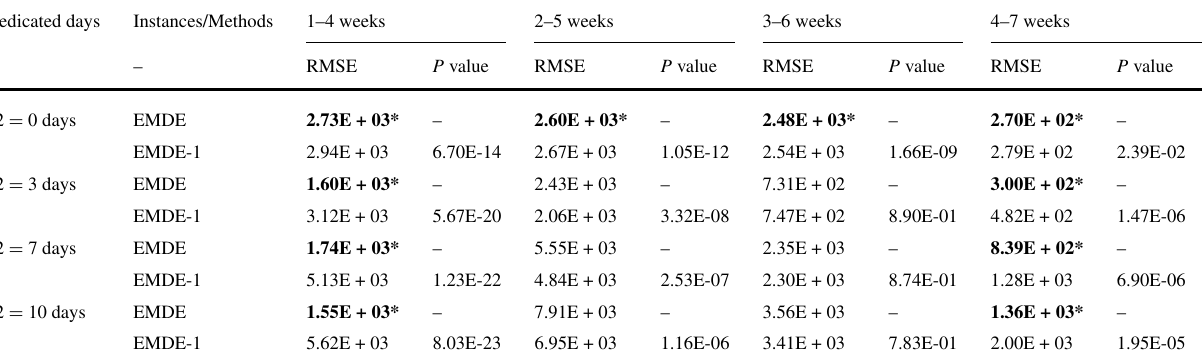
Table 6 Comparison results for the data-driven parameter optimization ( T 1 (cid:2) 21) Predicated